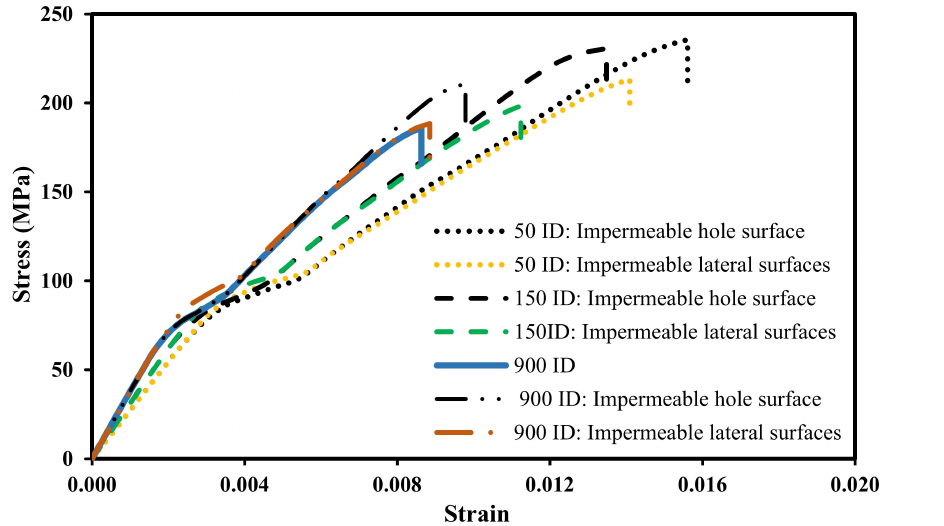
Figure 13. Prediction of the maximum stress for different impermeable